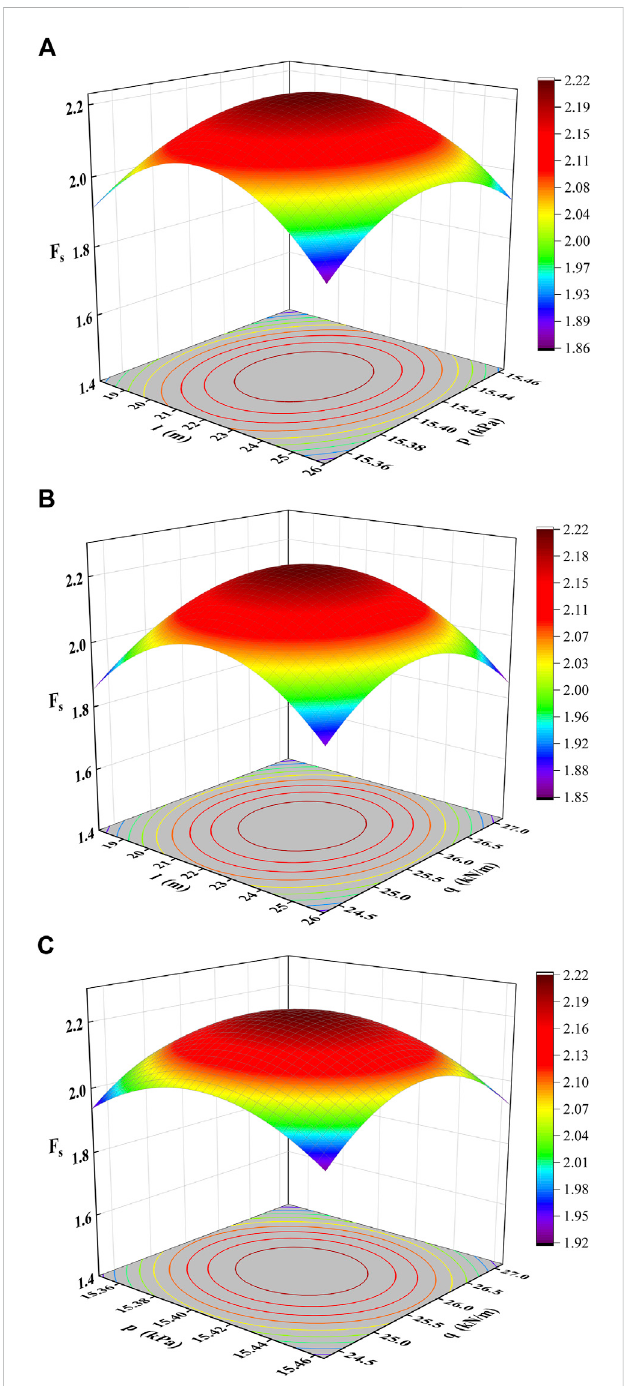
Response surface of the tunnel stability reserve factor in the region U (A) Response surface corresponding to support length l and support 2. pressure p. (B) Response surface corresponding to support length l and ground surcharge load q. (C) Response surface corresponding to support pressure p and ground surcharge load q